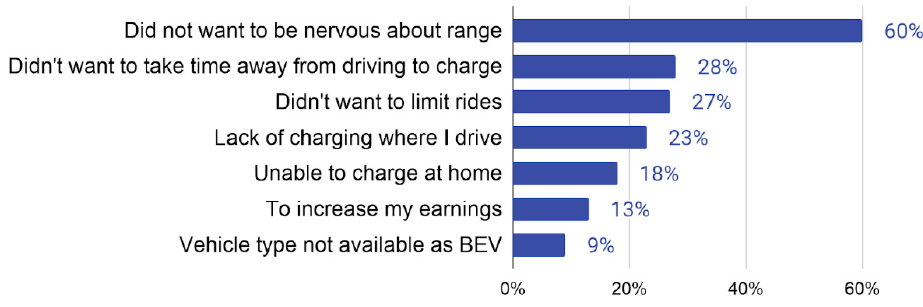
Figure 6. Reasons for choosing a PHEV over a BEV. Multiple answers allowed.